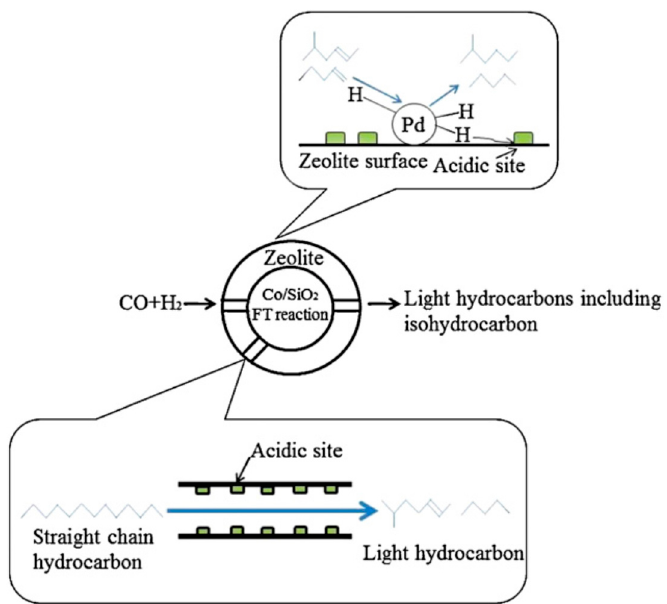
Figure 10. Schematic of the actions of the Co / SiO 2 -Z-Sp-Pd catalyst in the FTS reaction. Reprinted with permission from [78]. Copyright (2013) Elsevier Science BV, Amsterdam, Netherlands.